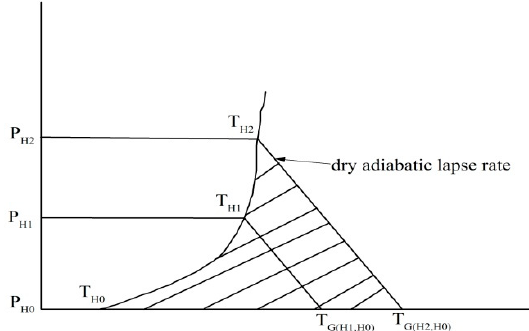
Figure 1. Diagrams for stable energy. The line TH0-TH1-TH2 is the detected temperature, T G is a function of H and h and is calculated by the increasing T with height from H to h (H0 ≤ h ≤ H) at